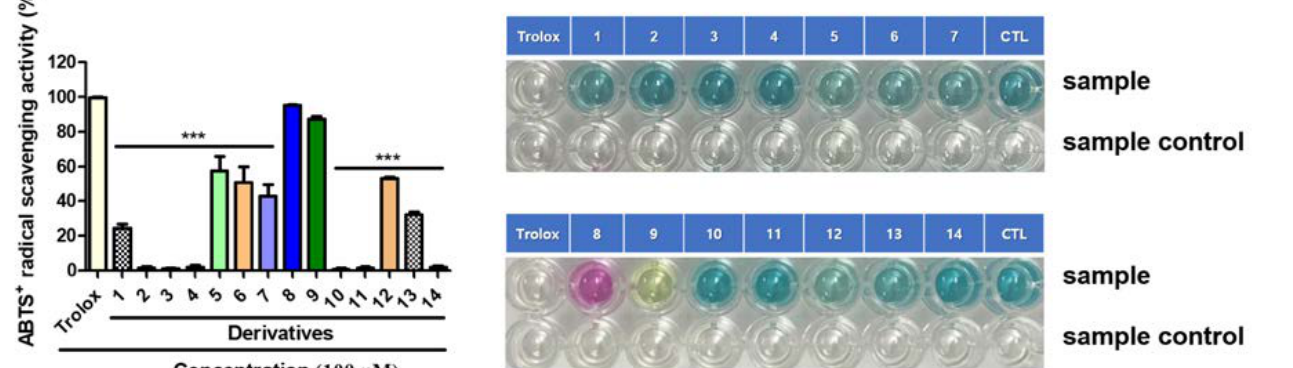
Figure 11. Radical scavenging activities of BABT derivatives 1 – 14 determined using a 2,2′ -azino- bis(3-ethylbenzothiazoline-6-sulfonic acid) (ABTS) assay. BABT derivatives 1 – 14 and Trolox, the positive reference control, were used at a concentration of 100 µM. An ABTS radical solution in the absorbance range of 0.70 ± 0.02 at 734 nm was used, and the absorbances of the test samples were measured at a wavelength of 734 nm after maintaining them in the dark at room temperature for 2 min. CTL indicates the control. All experiments were performed independently, thrice; the asterisk symbol (*) indicates the significant differences between BABT derivatives and Trolox. *** p < 0.001 for cells treated with BABT derivatives vs. cells treated with